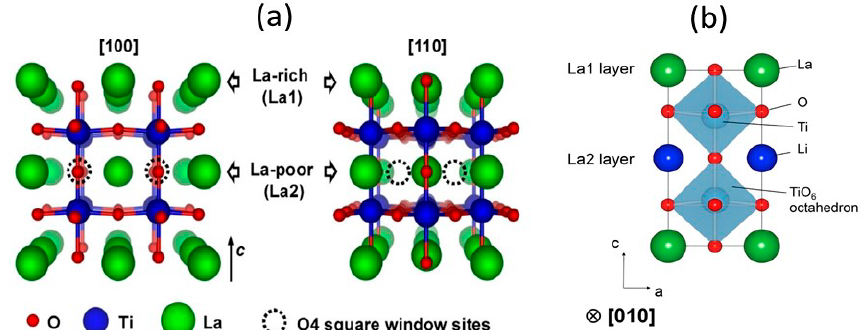
Figure 34. ( a ) Perspective views of the Li 3 x La (2/3) − x □ (1/3) − 2 x TiO 3 perovskite network along the [100] p and [110] p zone axes (where “p” refers to the cubic pseudoperovskite structure). Li atoms are not illustrated on account of the uncertainties regarding their positions reported in the literature.